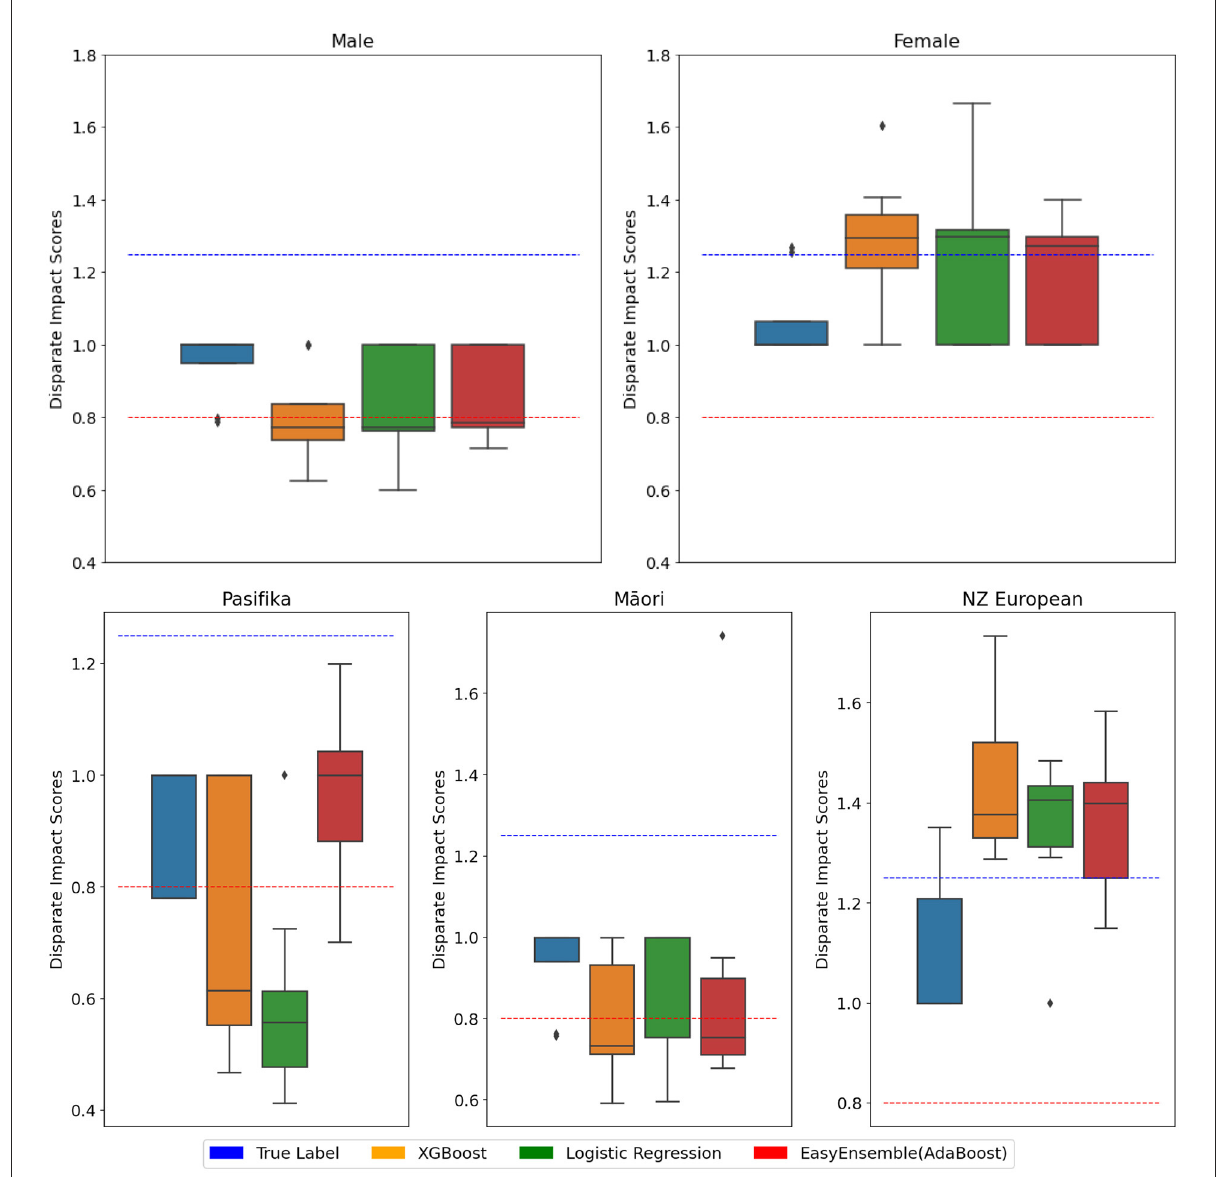
FIGURE5 NZ-GP Harms data with the target as patient Harm Status. Protected group: Gender (Top) , ethnicity (Bottom) . 10-cross-validation is performed using three classifiers, and the DI score is calculated at each fold. DI values of true values are also included. Each box plot ranges from minimum to maximum values of DI scores calculated at each fold. DI scores closer to 1 are better. DI < 0.8 implies bias against group (indicated by red line), DI > 1.25 implies bias for group (indicated by blue